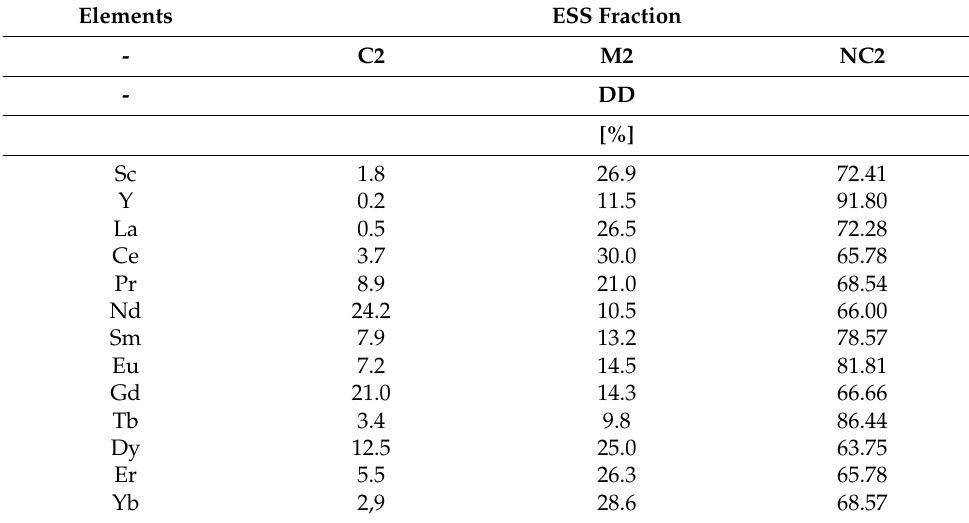
Table 13. Distribution of elements from the group of rare-earth